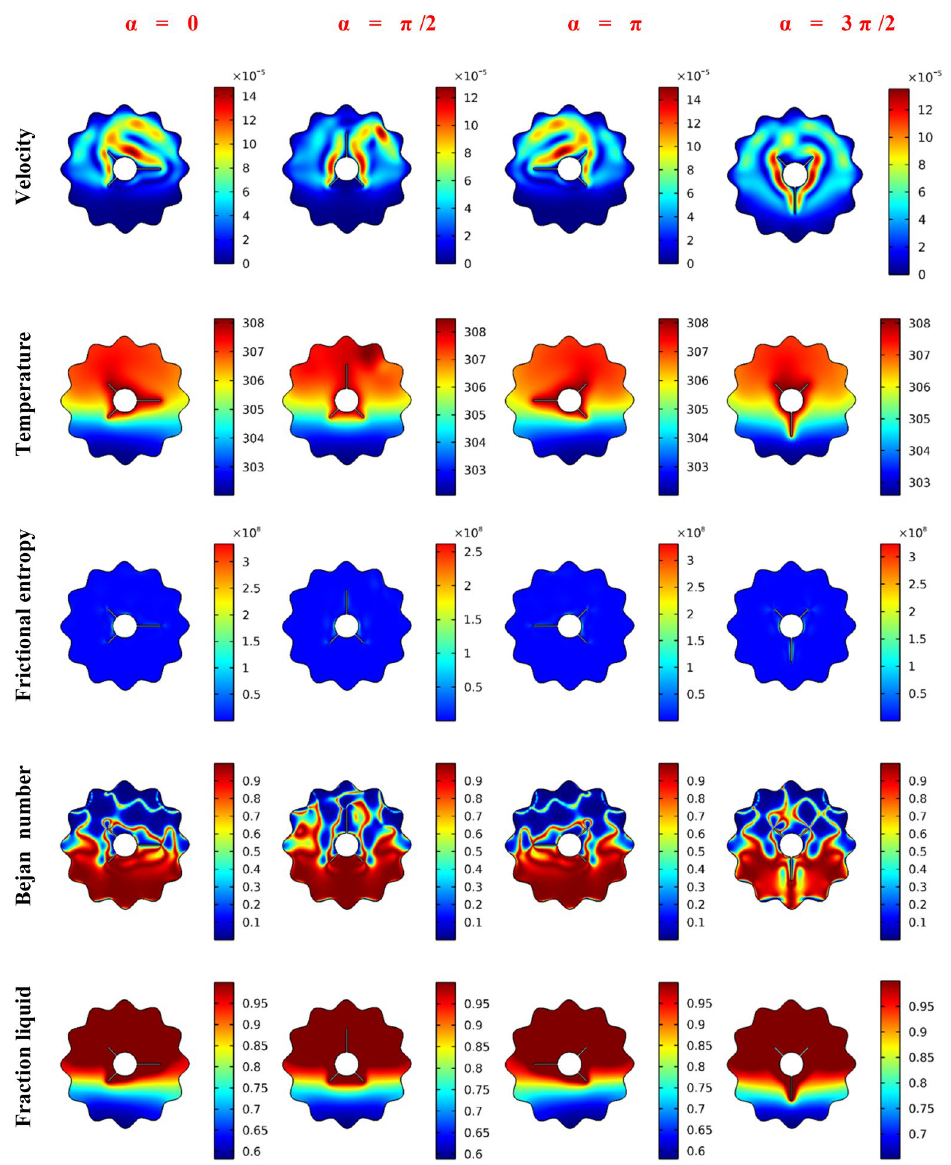
Figure 4. The impact of the finned tube orientation on the Velocity, Temperature, Frictional entropy, Bejan number, and Liquid fraction contour after 30